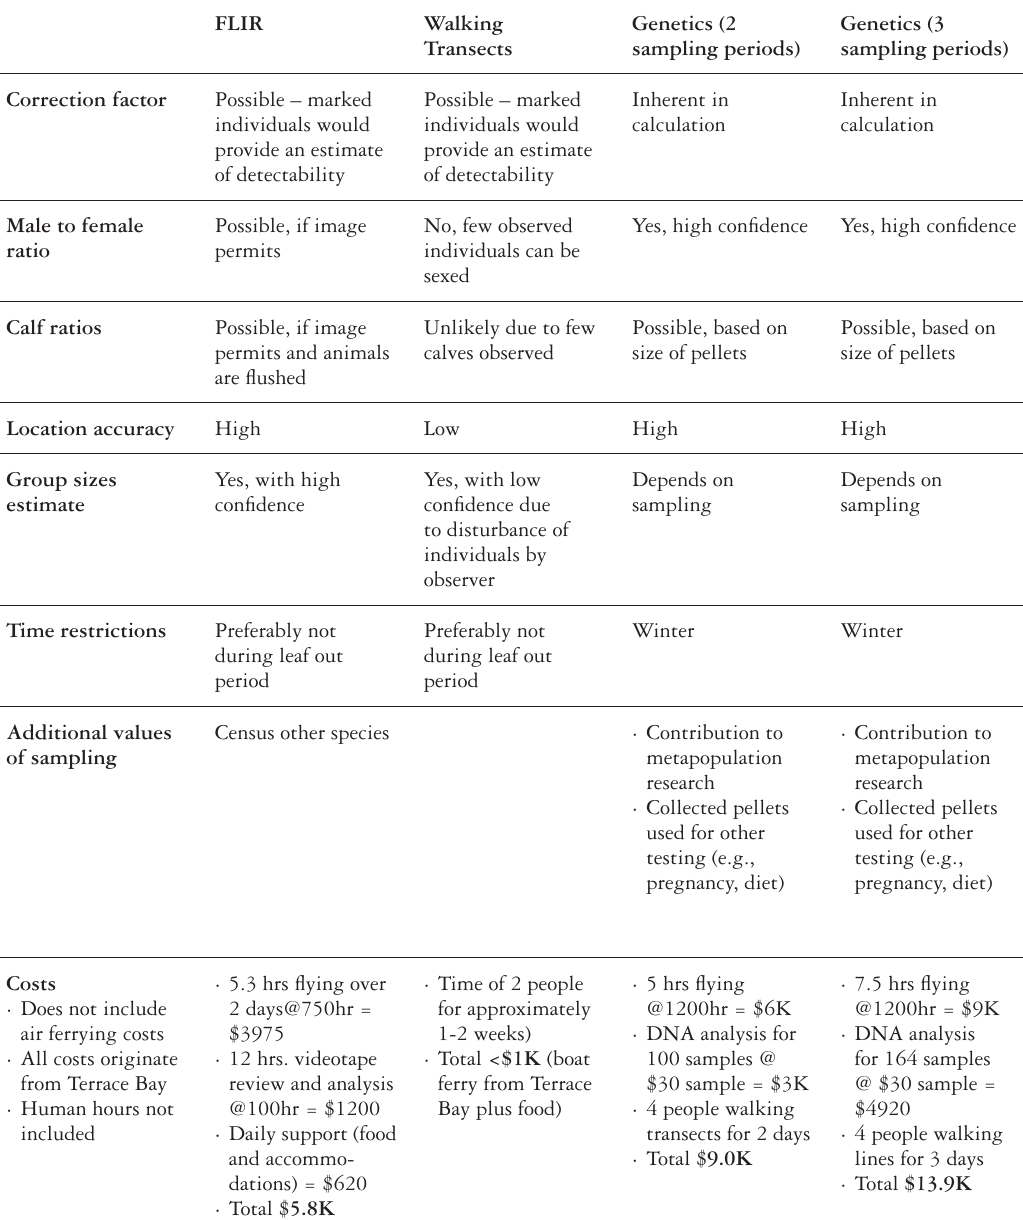
Table 2. Comparison of potential advantages, disadvantages and costs of three different techniques used to estimate woodland caribou population size on the Slate Islands,